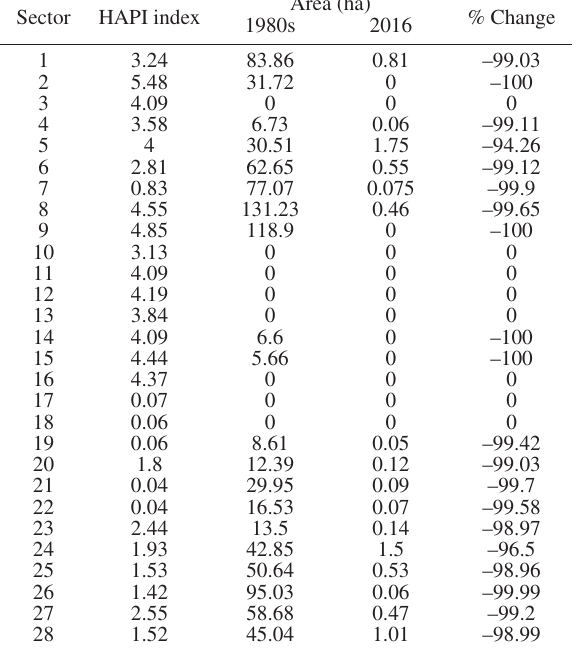
Table 2. – Values of the HAPI index, area covered and rate of tem- poral change of Cystoseira abies-marina in each of the 28 sectors along the coastal perimeter of Gran Canaria.